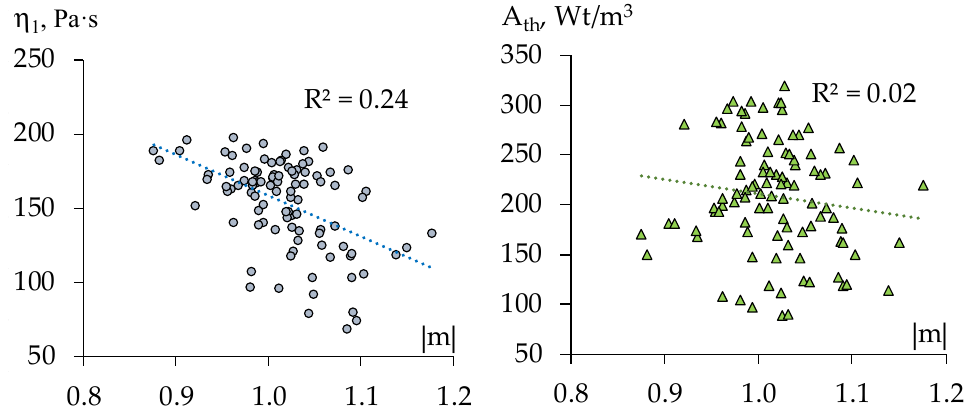
Figure 9. Scatter diagrams obtained in computational experiments at the lowest content of perlite and methylcellulose (x 2 = x 3 = –1).